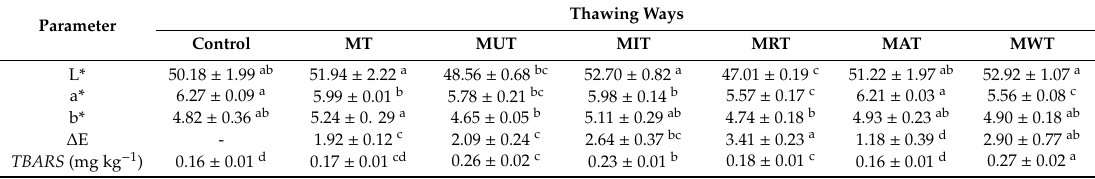
Table 2. Changes in color and thiobarbituric acid-reactive substances ( TBARS) values of pork samples under six di ff erent thawing conditions. Parameter